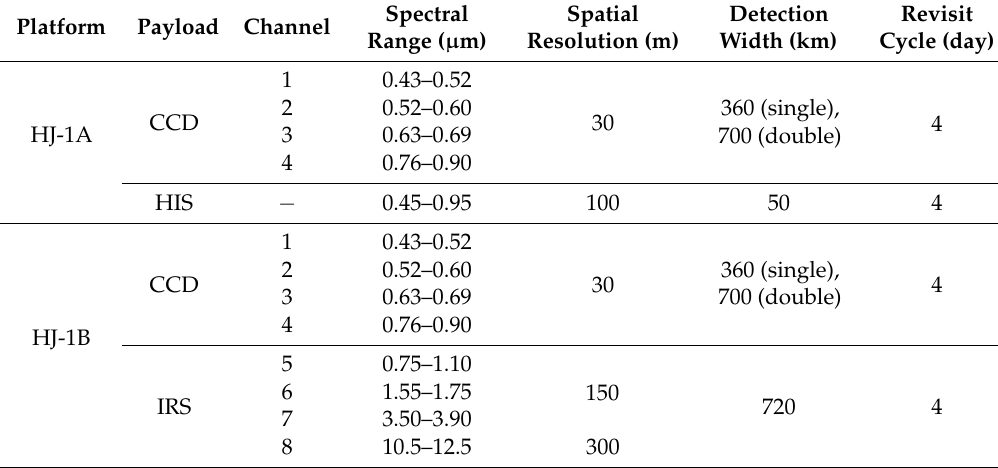
Table 2. Major load parameters of HJ-1A/B